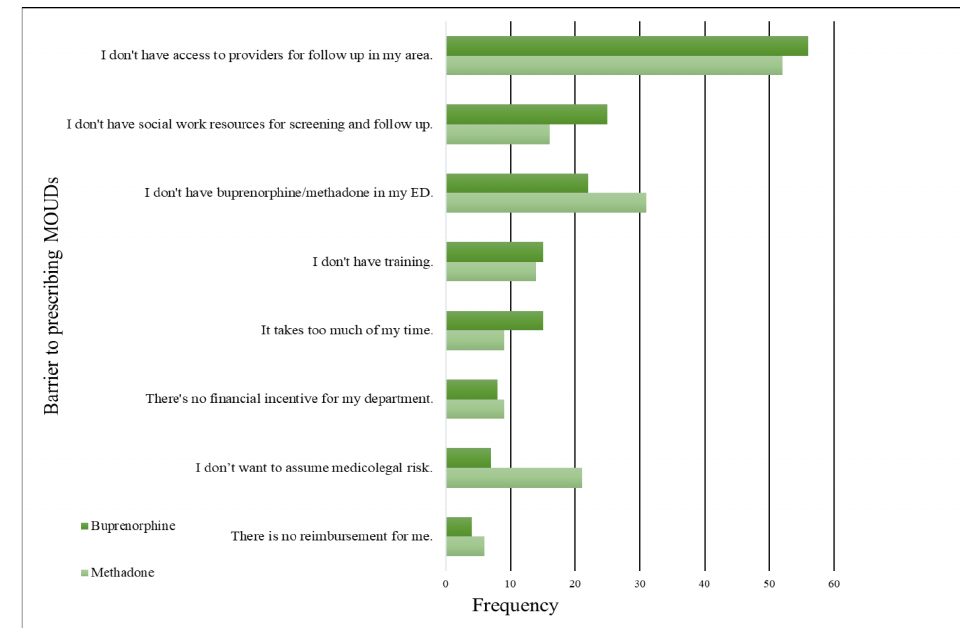
Figure 2. Highest perceived barrier by frequency for prescribing methadone or buprenorphine. MOUD , medication for opioid use disorder; ED , emergency